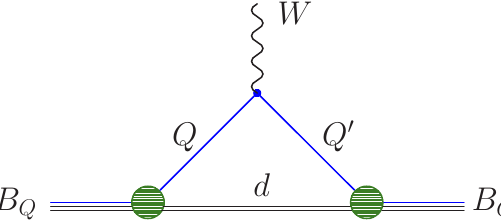
Figure 1. The schematic diagram of the weak decay of a heavy baryon. The W boson produces the lepton pair (cid:96) ν (cid:96) . Green circles denote the baryon wave functions, the blue line corresponds to the heavy quarks Q and Q (cid:48) in the initial B Q and final baryon B Q , (cid:48)